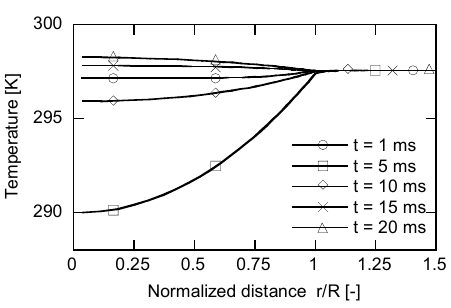
Distribution of temperature inside and outside of bubble in the case Δ p = 90 kPa.